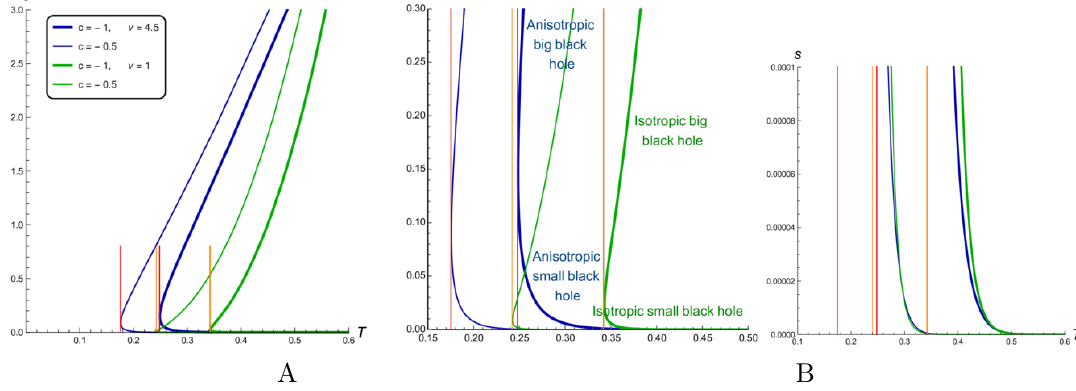
Figure 23 . The black hole entropy s ( T ) for (cid:22) = 0 and di(cid:11)erent c in isotropic (green lines) and anisotropic (blue lines) cases (A); regions located near the minimum temperatures T min ( c; (cid:23) ) with an increased scale on the right (B); the red vertical lines indicate T min ( c; 4 : 5) and the orange ones indicate T min ( c; 1) for c = (cid:0) 0 : 5 and c = (cid:0)